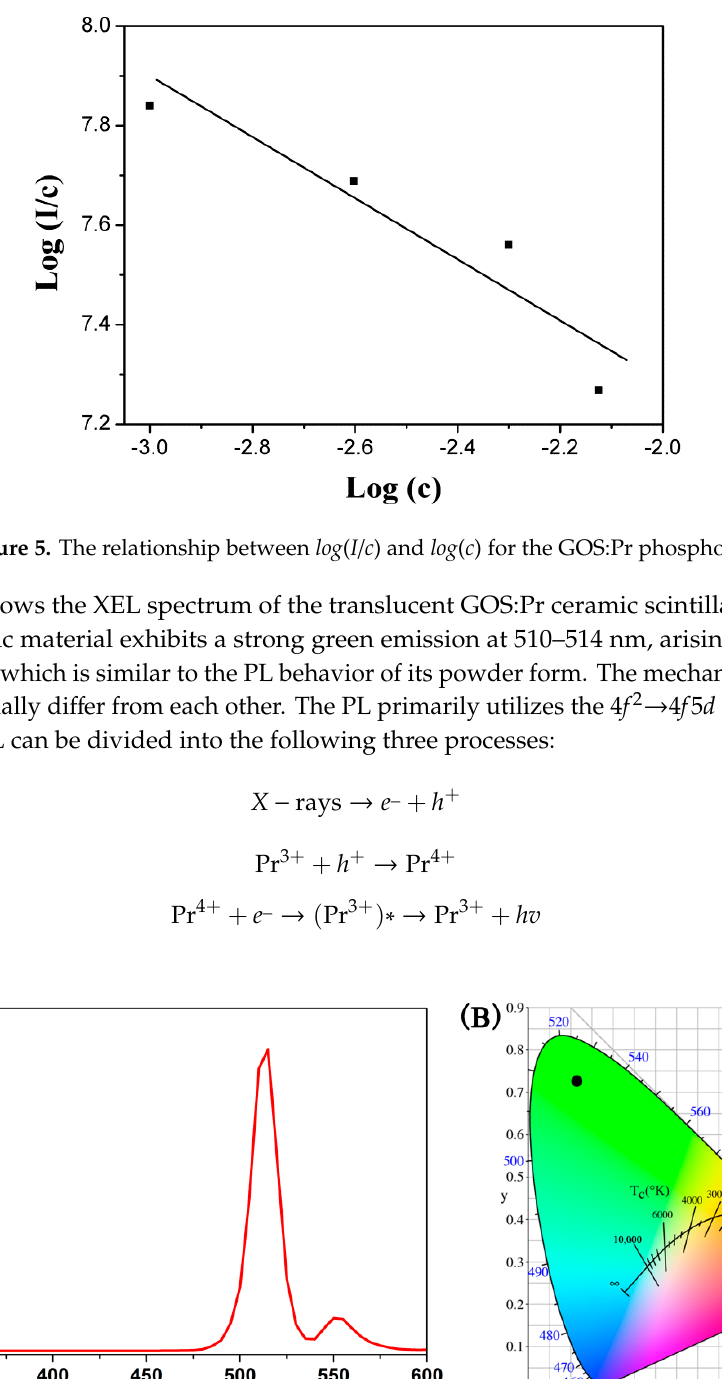
Figure 6. X-ray excited luminescence (XEL) spectrum of the translucent GOS:Pr ceramic scintillator ( A ) and its 1931 CIE chromaticity diagram ( B ).